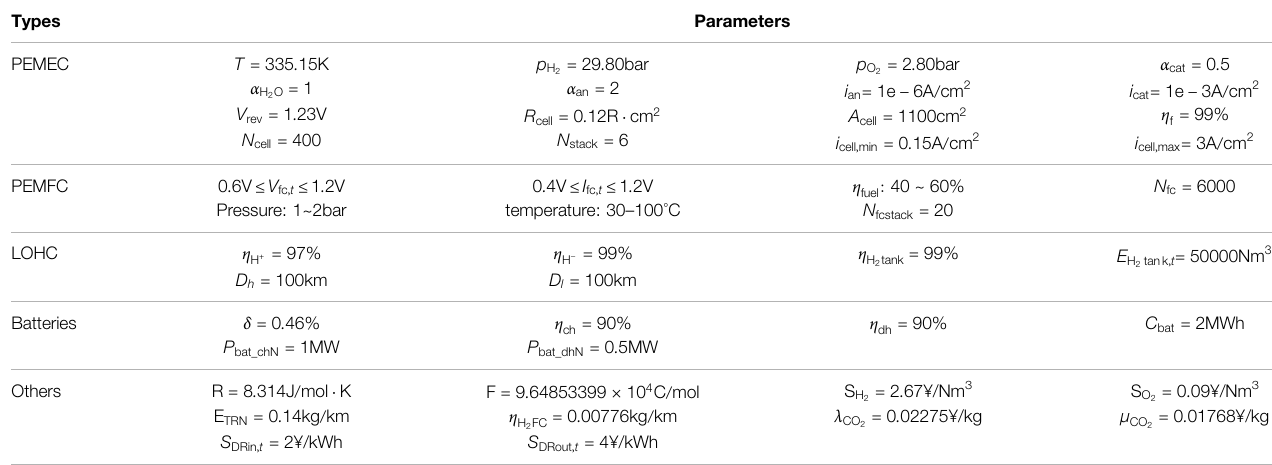
TABLE 1 | Parameters of the simulation example.